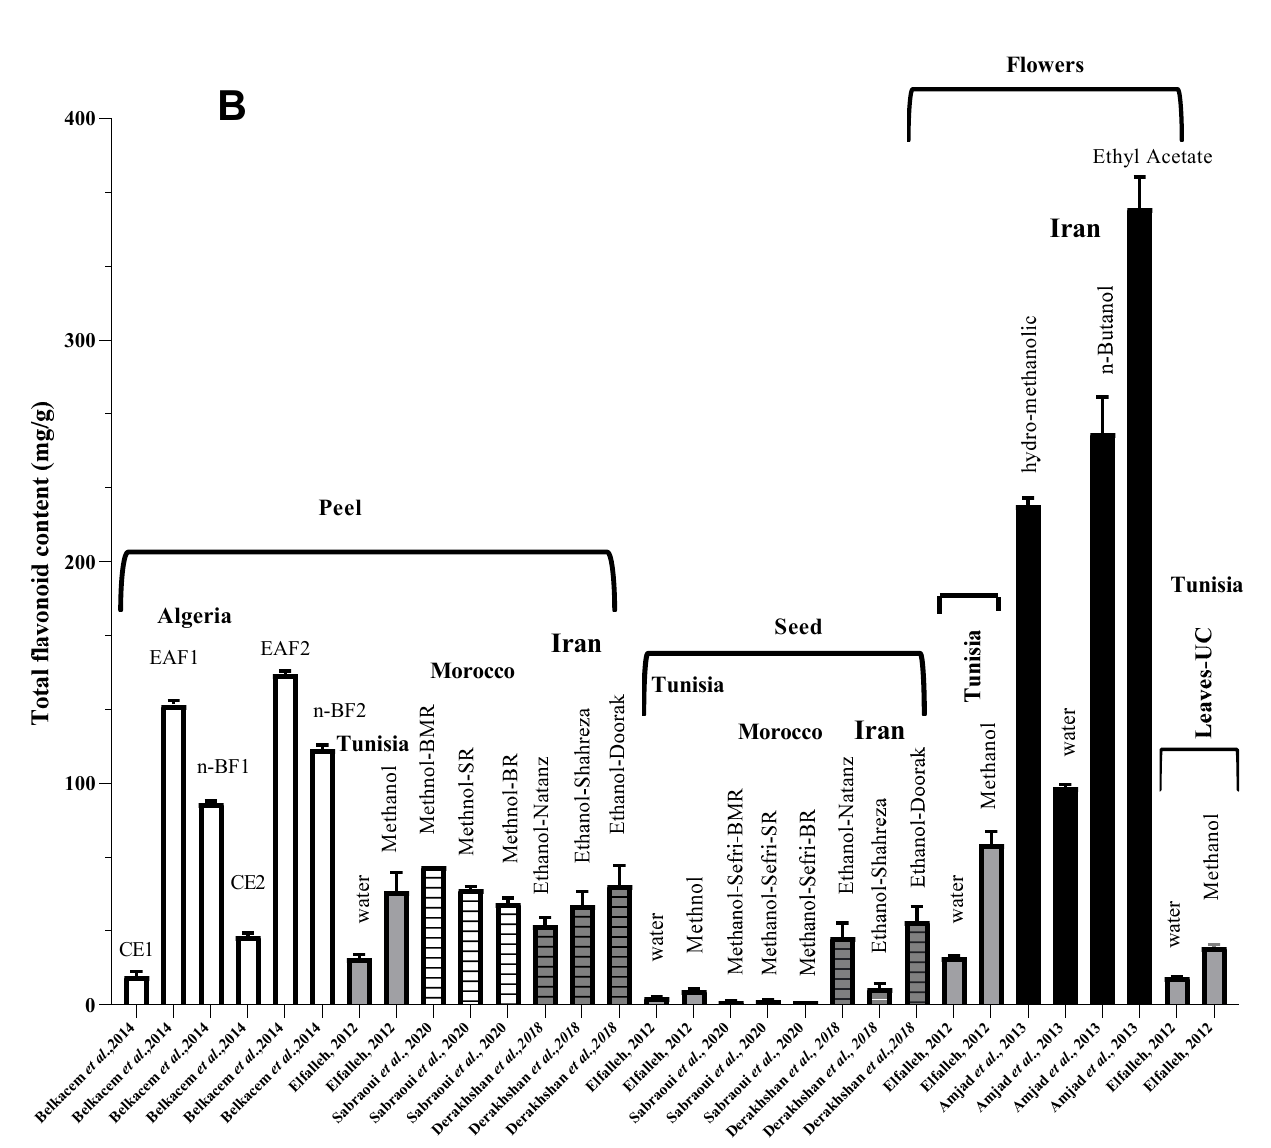
Figure 2. ( A ) Total phenolic content in peels, seeds, and leaves of pomegranate fruit growing in different regions of the world [49,50,52,54–56]. BR: Berkane region; SR: Statte region; BMR: Beni Mellal region; UC: unknown cultivar; MWE: methanol/water extract; n-BF1: n-butanol fraction of hydromethanolic extract; CE2: aqueous-acetone crude extract; EAF2: ethyl acetate fraction of aqueous-acetone extract; n-BF2: n-butanol fraction of aqueous-acetone extract; Chelfi-ES: chelfi exposed to sun; Chelfi IC: Chelfi in shade. ( B ) Total flavonoid content in pomegranate leaves, peels, seeds, and flowers, from different geographical areas of the world [49,52–54,56]. BMR: Beni-mellal region; SR: Statte region; BR: Berkane region; UC: unknown cultivar. As shown, the Iranian and Algerian varieties seem to accumulate very important quantities of these bioactive constituents. Furthermore, the final results are sensitive to different factors such as the solvent used for the extraction, genetic variabilities, variety, and the geoedaphic and climatic conditions that characterize each